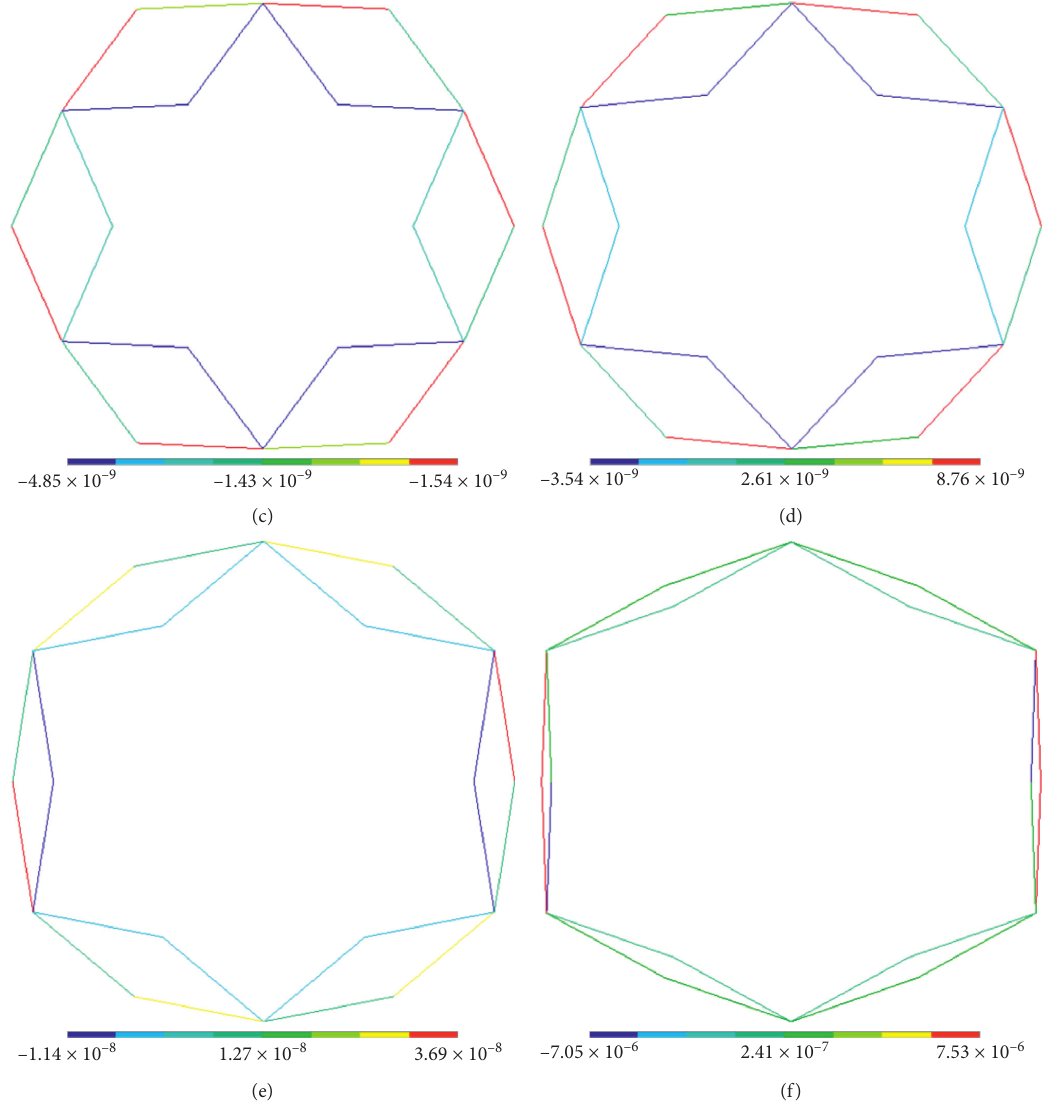
Figure 9: Axial strain for the deployable structure during the motion process. (a) Time: 0.2 s. (b) Time: 0.6s. (c) Time: 1 s. (d) Time: 1.4s. (e) Time: 1.8s. (f) Time: